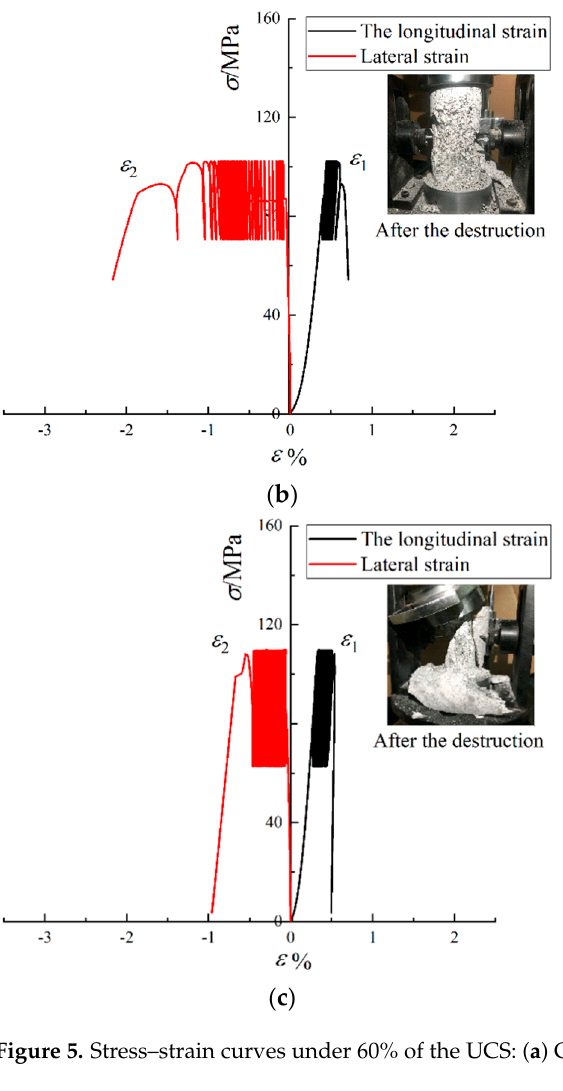
Figure 5. Stress–strain curves under 60% of the UCS: ( a ) Gra60% − 1; ( b ) Gra60% − 2; ( c ) Gra60% − 3.